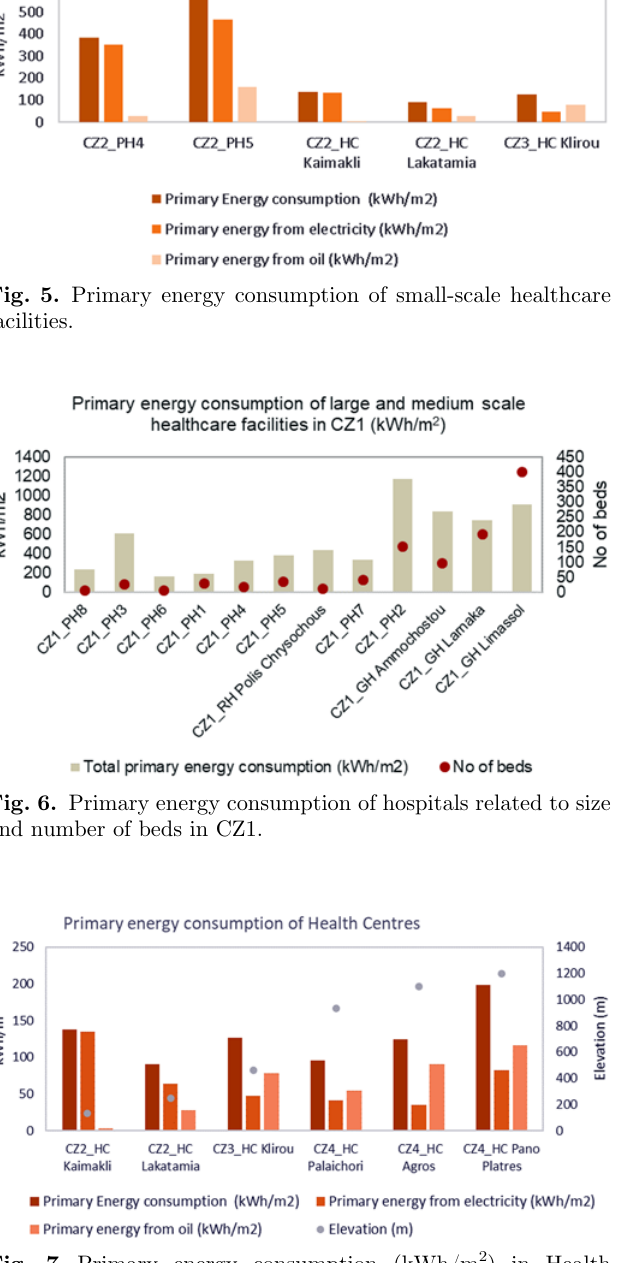
Fig. 7. Primary energy consumption (kWh/m 2 ) in Health Centres located in different climate